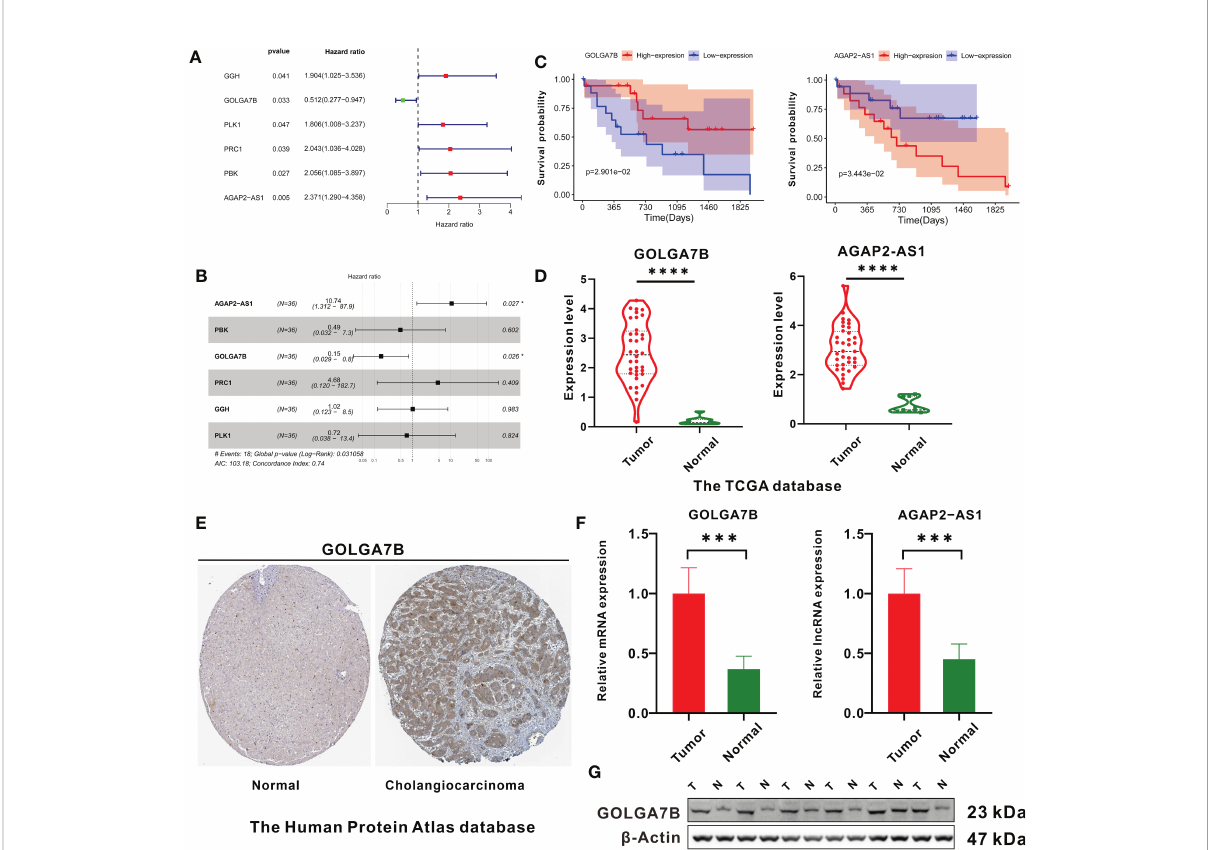
FIGURE 3 Identi fi cation of key genes related to CCA patient survival. (A) The forest plot shows the six survival-related genes in the yellow module identi fi ed by univariate Cox regression analysis. (B) Forest plot showing that GOLGA7B and AGAP2 − AS1 were independent survival-related genes determined through multivariate Cox regression analysis. (C) Kaplan – Meier curves showing that CCA patients with higher expression of GOLGA7B had a high survival probability, and those with a higher expression of AGAP2 − AS1 had a lower survival probability. (D) mRNA expression of GOLGA7B and AGAP2 − AS1 between tumor and normal tissues in CCA patients in the training group. (E) Analysis of Human Protein Atlas database indicated that GOLGA7B protein expression was signi fi cantly upregulated in CCA tumor tissues compared with cholangiocytes. The CCA tumor tissue came from a 67-year-old man (patient ID: 3334; staining: medium; quantity: 25%-75%; intensity: moderate). The normal tissue came from a 55-year-old man (patient ID: 2399; staining: not detected; quantity:<25%; intensity: weak). (F) qRT-PCR con fi rmed that GOLGA7B and AGAP2 − AS1 were overexpressed in tumor samples compared to normal tissue samples. (G) Western blotting con fi rmed that the protein expression of GOLGA7B was signi fi cantly upregulated in tumor samples compared with normal tissue samples. * P <0.05; *** P <0.001; **** P